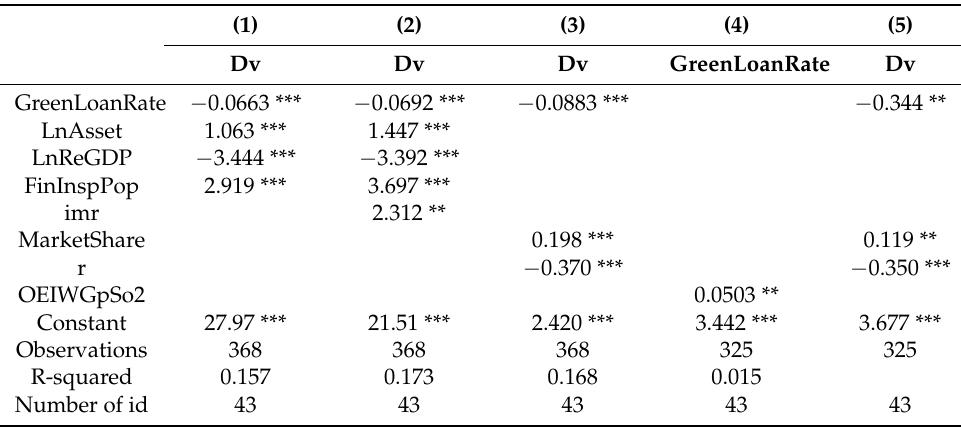
Table 8. The regression results of the endogenous